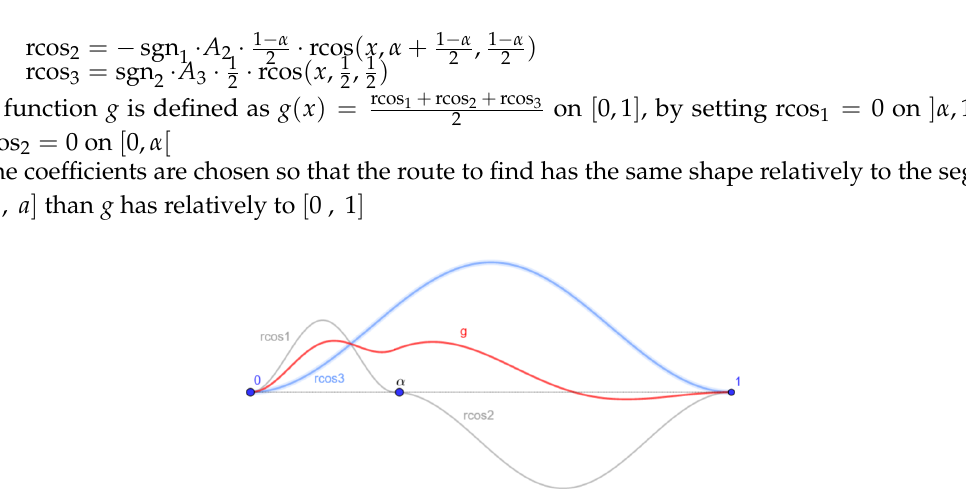
Figure 6. The raised cosine functions to determine the biases in a general case.